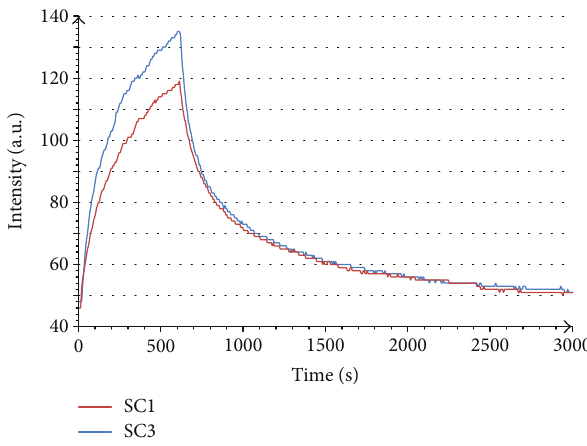
Figure 11: Plot of the intensity as a function of time, as obtained from thermographic analysis performed on SC1 and SC3